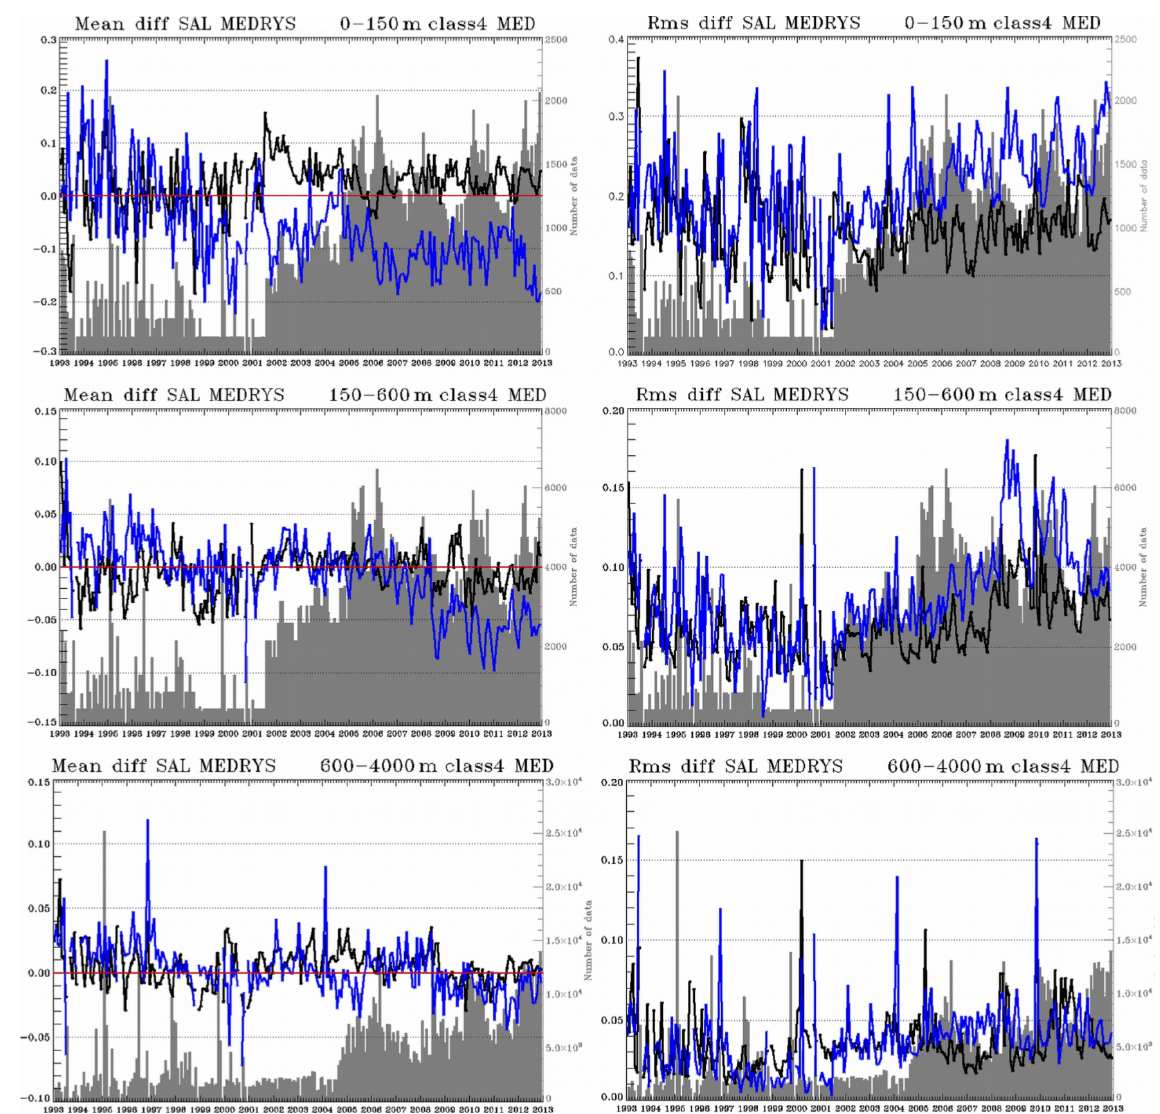
Figure 13. Same as Fig. 12 but for salinity